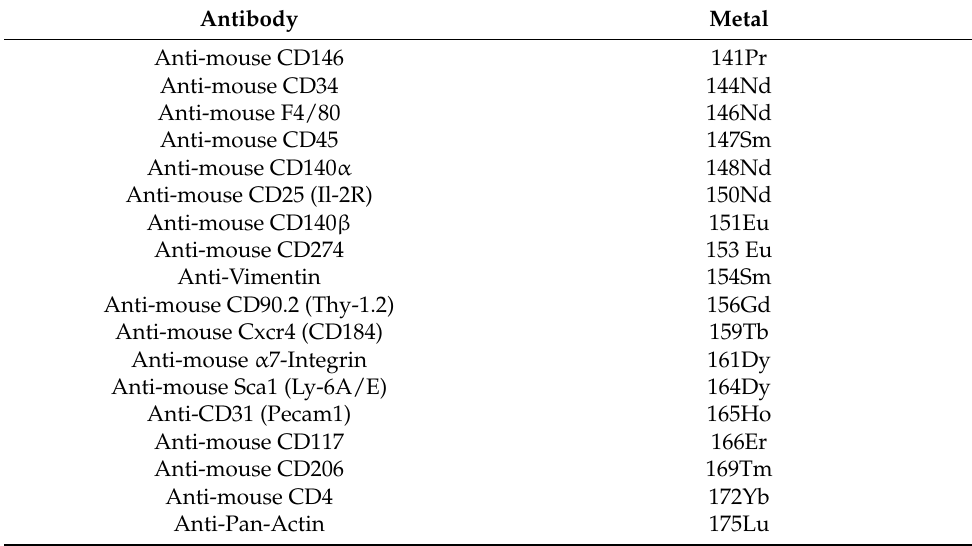
Table 1. List of the metal-tagged antibodies used in the mass cytometry